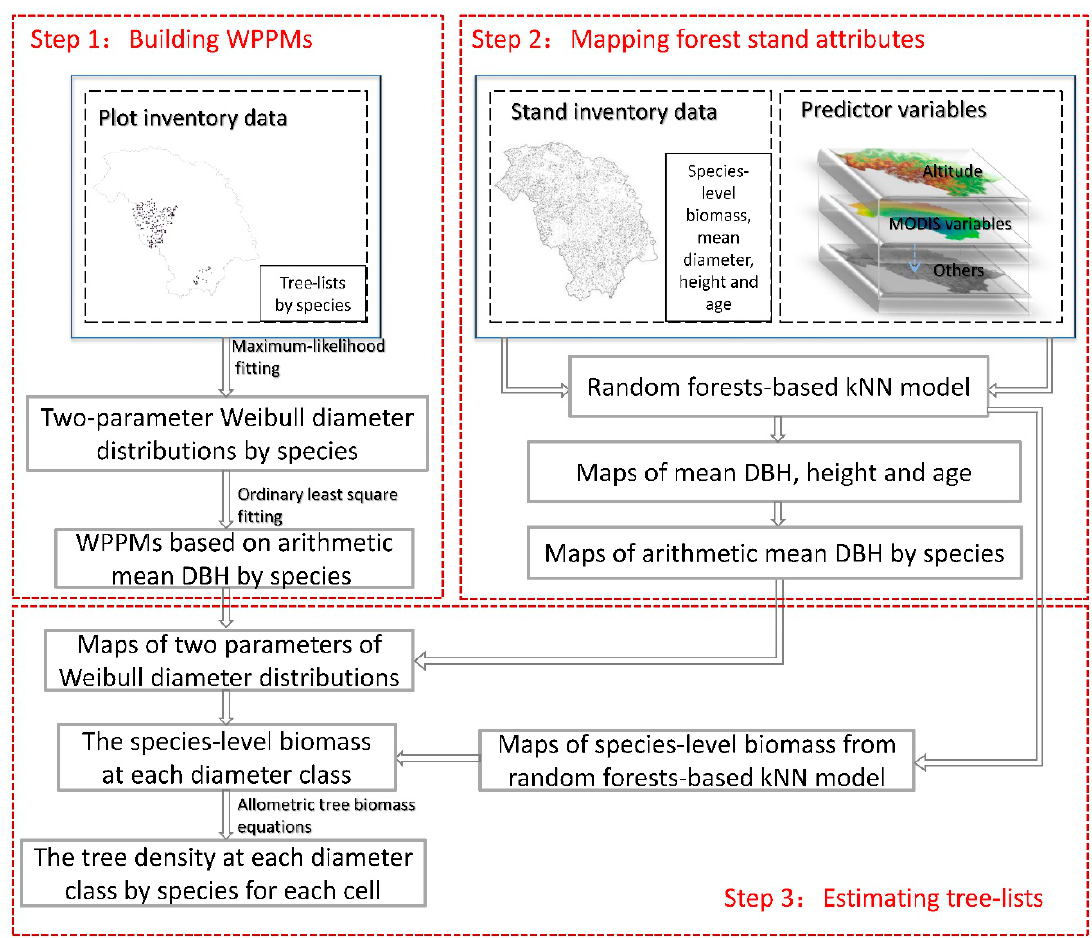
Figure 2. The overall framework of generating tree-lists. DBH: Diameter at breast height; kNN, k-nearest neighbor; WPPMs, Weibull parameter prediction models by species.